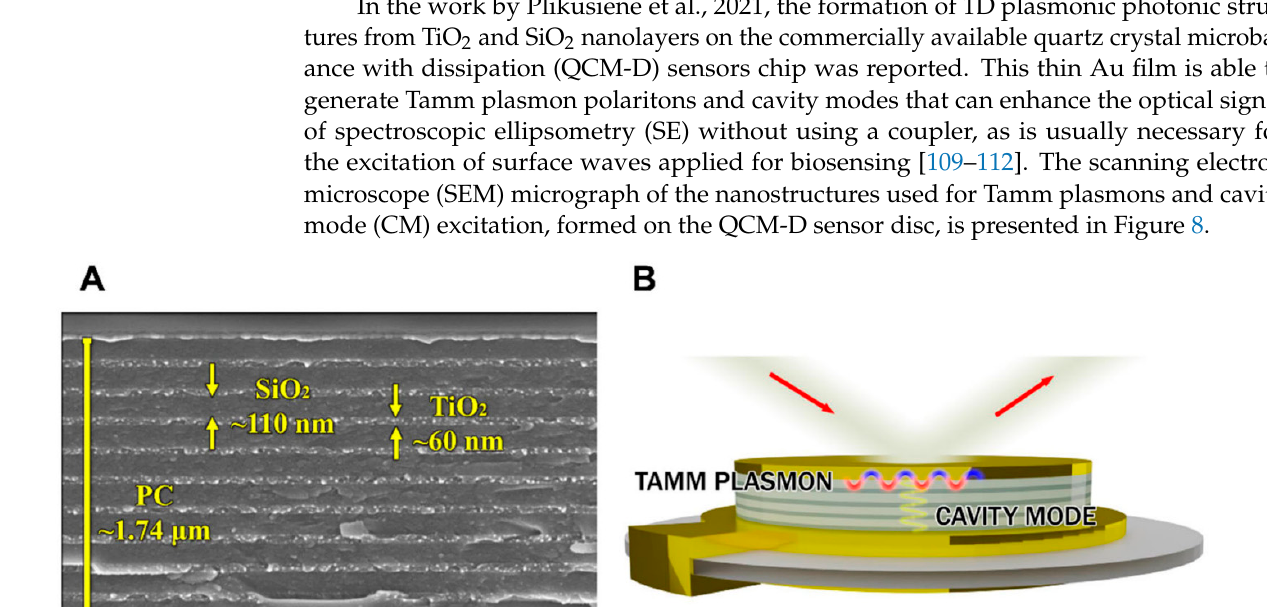
Figure 7. Total internal reflection geometry schematic of the Au (a) and PC/Au (b) samples with a self-assembled monolayer of 11-mercaptoundecanoic acid (11-MUA) and the GCSF-R or BSA pro- tein in phosphate-buffered saline solution. Adopted from [105].